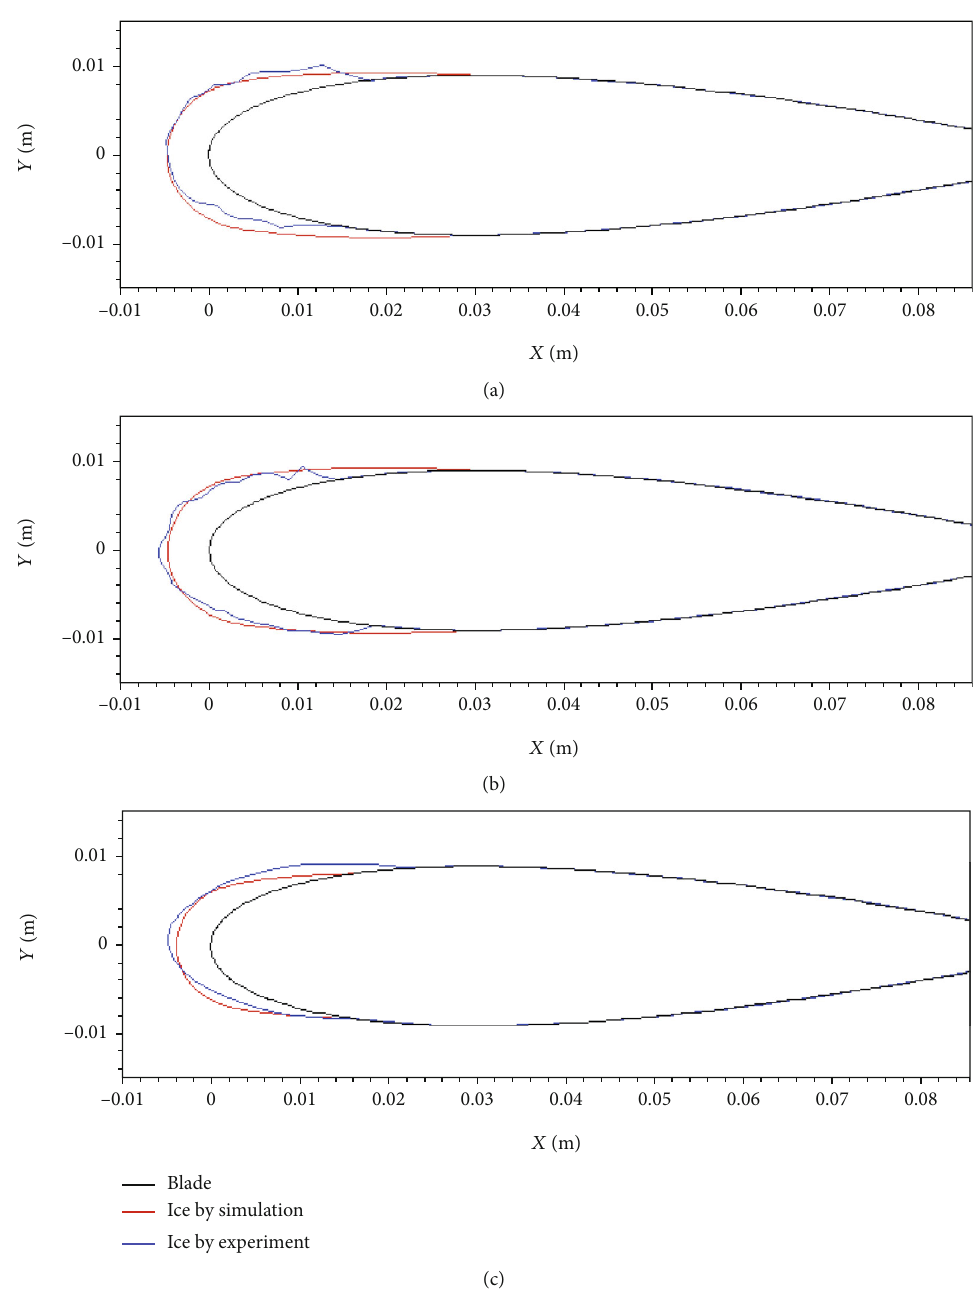
Figure 15: Ice shape comparison of NACA0018 icing: (a) glaze ice, (b) mixed ice, and (c) rime